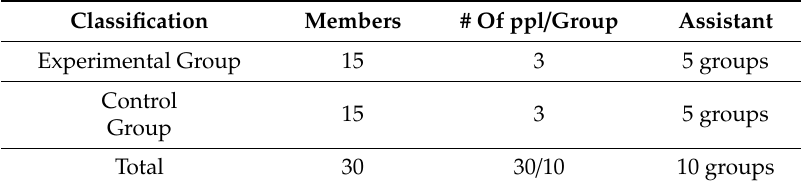
Table 7. Research Target Selection.